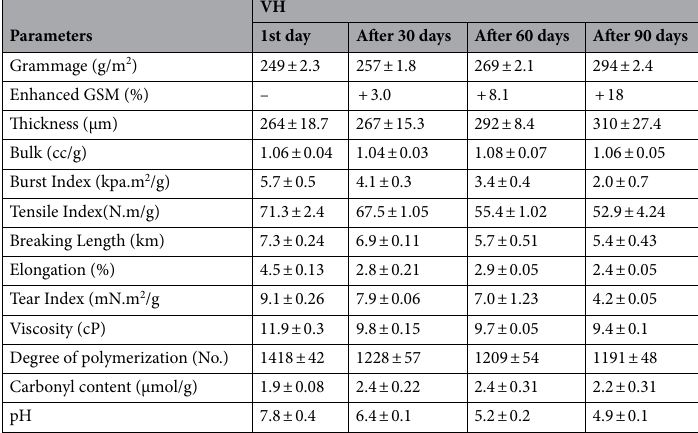
Table 3. Mechanical properties of unbleached pulp sheets exposed to